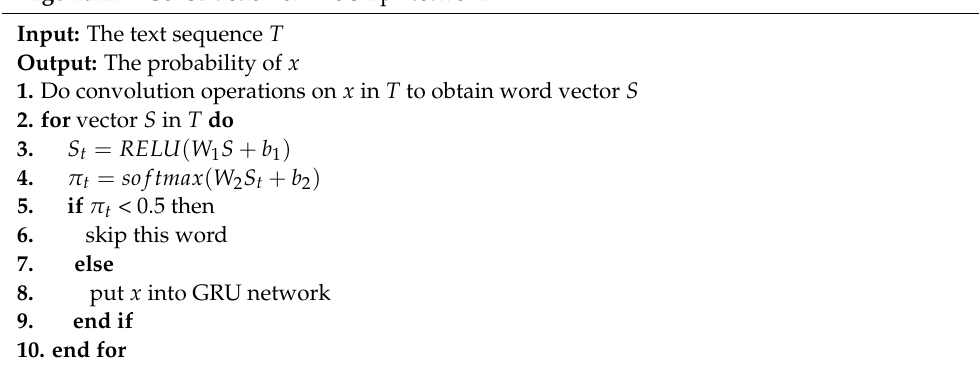
Algorithm 1 Construction of The Skip Network